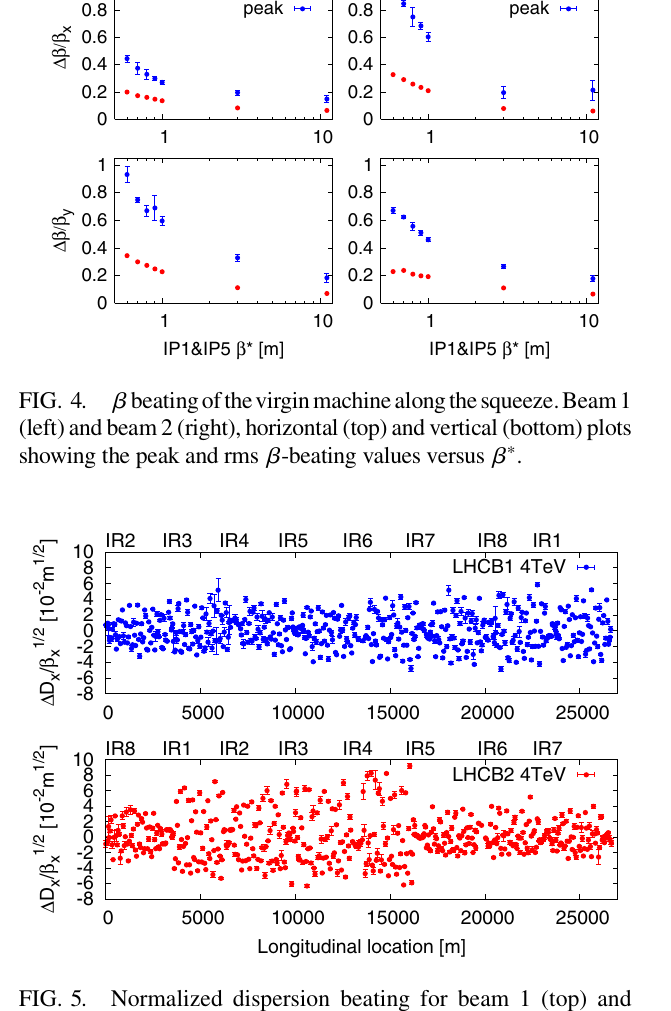
FIG. 5. Normalized dispersion beating for beam 1 (top) and beam 2 (bottom) for the virgin machine at (cid:1) (cid:1) ¼ 0 : 6 m